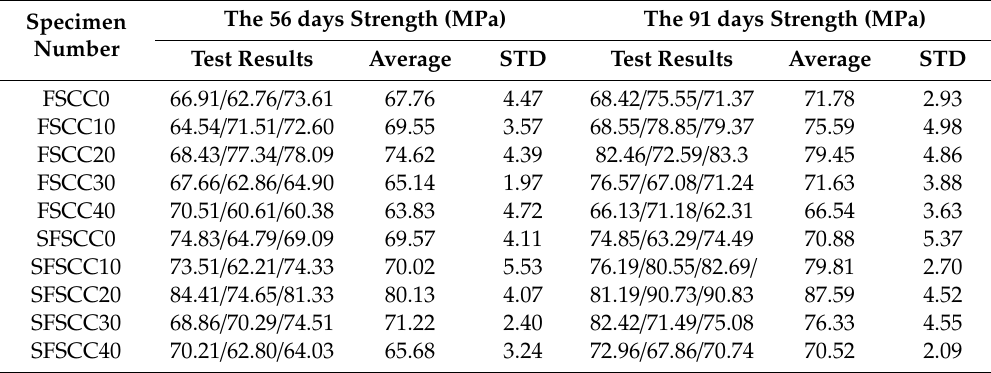
Table 5. Test results of 56 days and 91 days compressive strength of